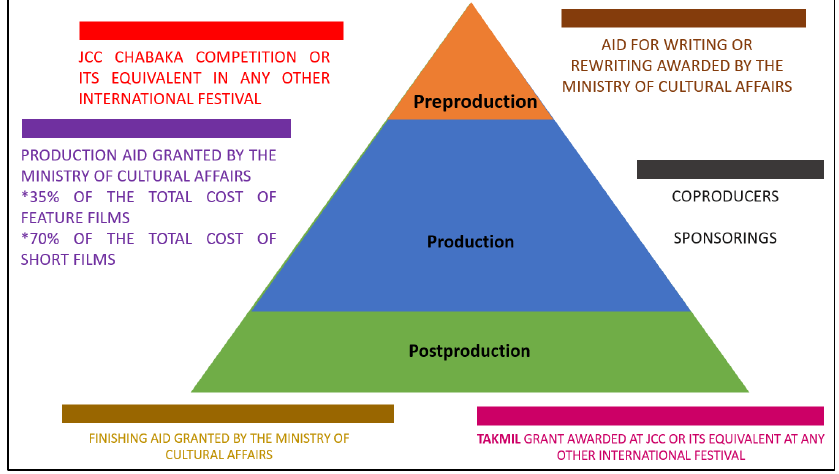
Figure 18: Variation of funding sources, according to the life cycle of a film (Tunisia Case